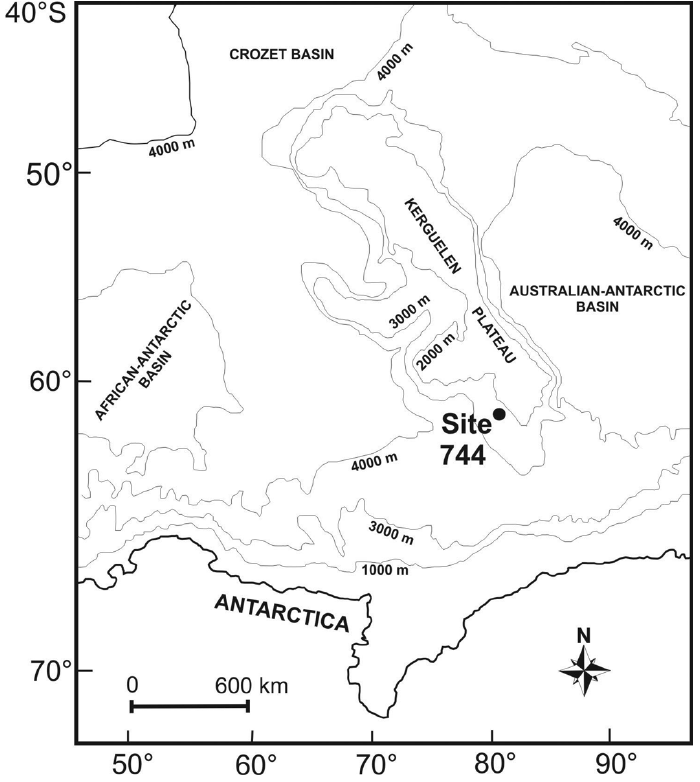
Fig. 1 – Map of the study area and the location of the ODP site